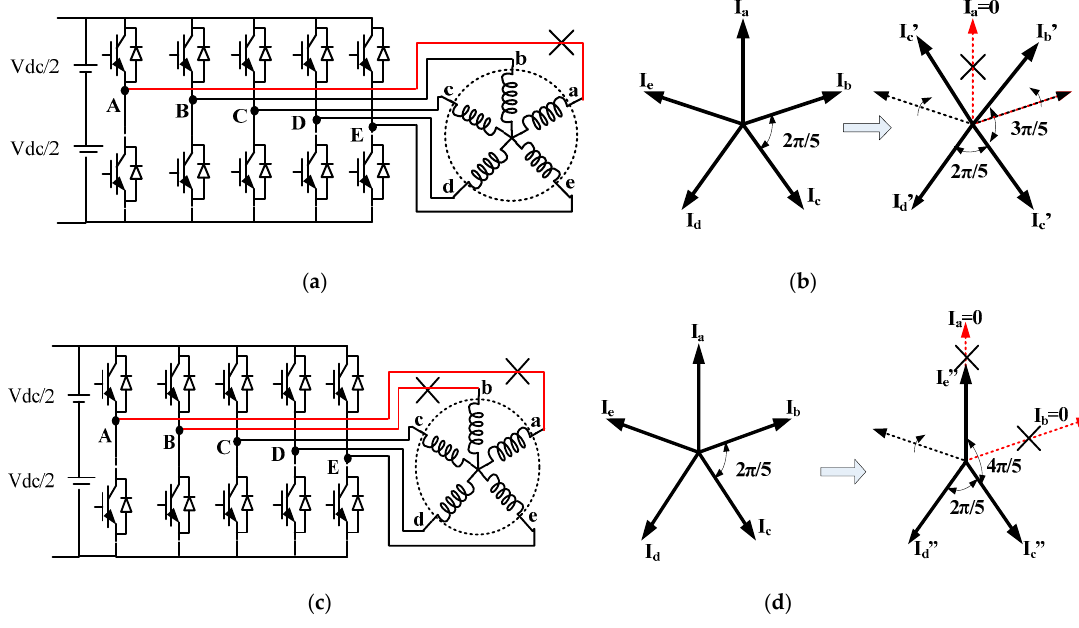
Figure 2. ( a ) five-phase system with 1-Ph circuit fault; ( b ) vector reconfiguration during 1-Ph open fault; ( c ) five-phase system with A2-Ph open circuit fault; ( d ) vector reconfiguration during A2-Ph open circuit fault.